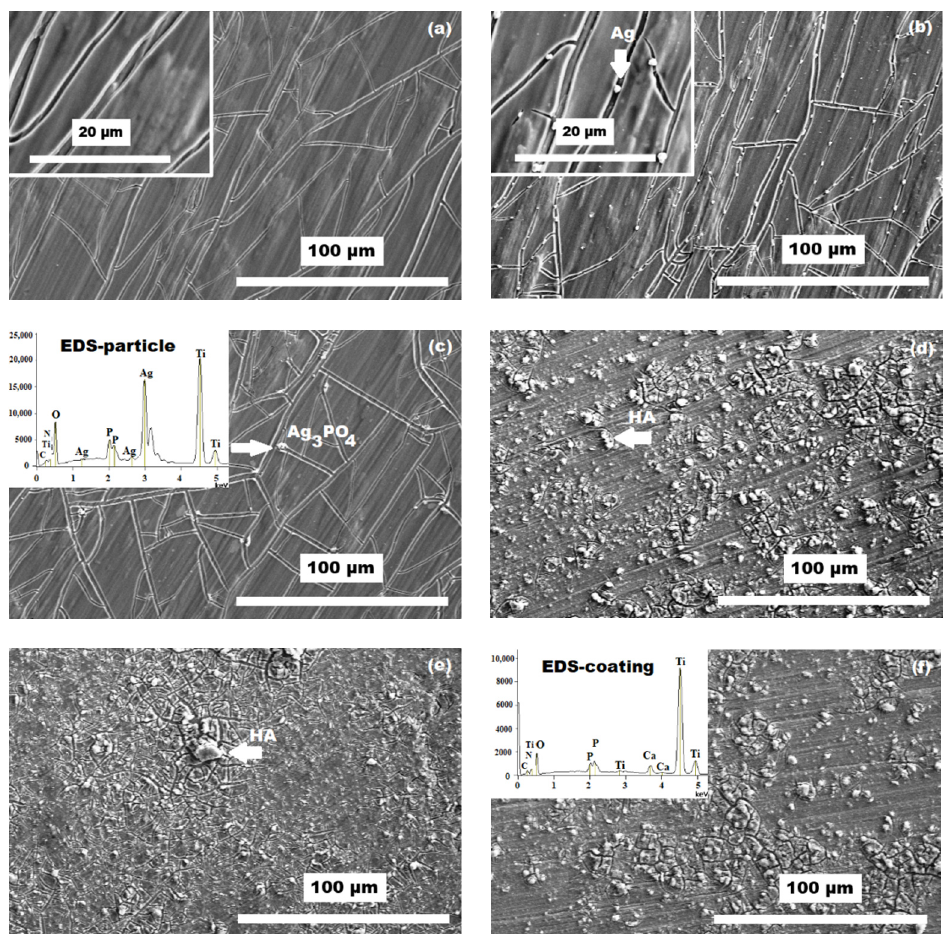
Figure 2. Surface of coatings after heating: ( a ) T, ( b ) TAN ( c ) TAP, ( d ) THA, ( e ) TANHA ( f ) TAPHA.